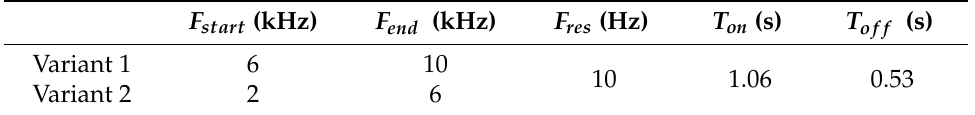
Table 3. Characteristics of the PS excitation signal.